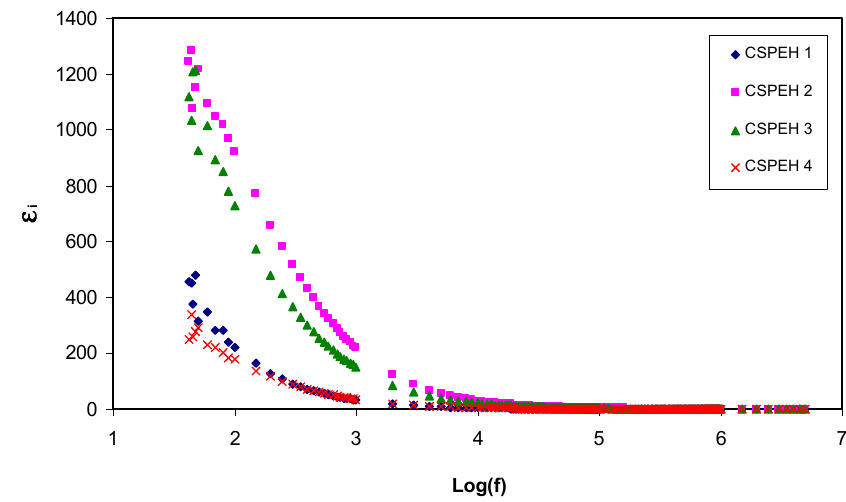
Figure 6. Dielectric constant in opposition to frequency logarithmic scale for the electrolytes.